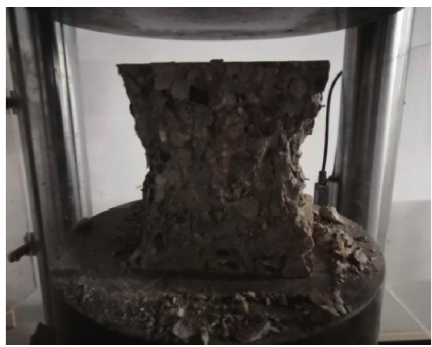
Figure 3: Compression test of